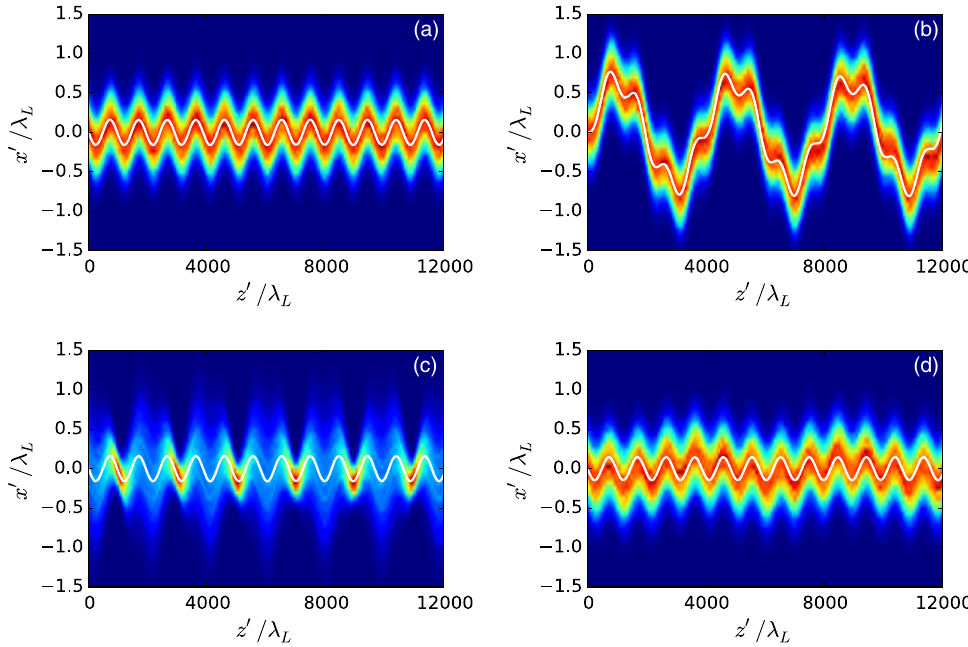
FIG. 3. Electron beam evolution inside the plasma undulator. The color image at each position z 0 represents the distribution of the x 0 positions of the beam electrons, and the white solid line is the analytical solution for the single electron obtained from Eq. (24). (a) The case of a matched electron beam injected into the undulator with optimal conditions for minimizing the betatron amplitude: ðh x i ; h y iÞ ¼ ð − a = ð γ Ω Þ ; 0 Þ and ðh u i ; h u iÞ ¼ ð 0 ; − a Þ . The exponential term is neglected. (b) Undulator structure is the same e; 0 e; 0 u 0 x; 0 y; 0 u as in case (a), but a matched electron beam is injected with ðh x e; 0 i ; h y e; 0 iÞ ¼ ð 0 ; 0 Þ and ðh u x; 0 i ; h u y; 0 iÞ ¼ ð 0 ; 0 Þ . (c) The case of an unmatched beam with optimal injection for the undulator structure the same as in case (a). (d) The case of a matched electron beam with optimal injection into the undulator [same as in (a)], with the exponential term included in the expressions for the transverse field as given by Eq.